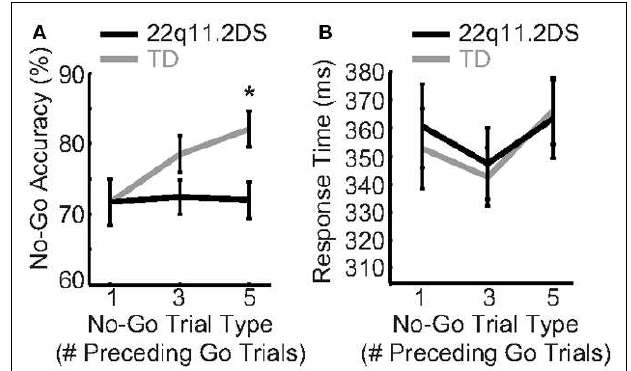
FIGURE 2 | Proactive response inhibition was typical in children with 22q11.2DS . (A) Accuracy and (B) response time on Go trials did not differ between groups.